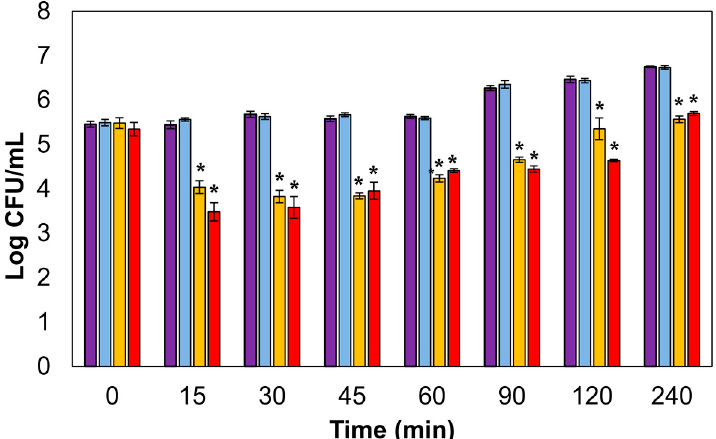
Figure 2. Lytic activity of liposome-encapsulated LysRODI against S. aureus Sa9 in tryptic soy broth (TSB; pH 5). Purple bar: untreated control culture; light blue bar: culture treated with empty liposomes; yellow bar: culture treated with encapsulated LysRODI; red bar: culture treated with free LysRODI. *, p -value < 0.05.